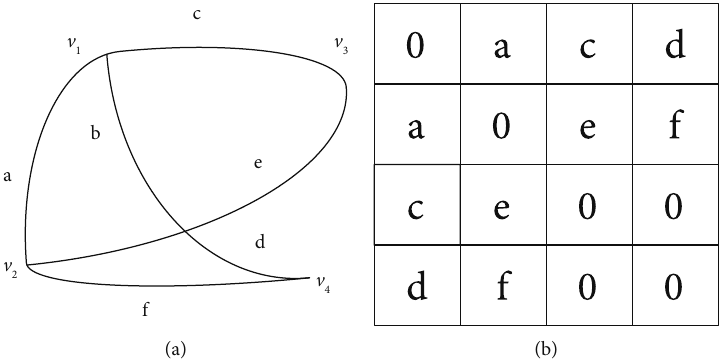
Figure 3: Basic representation of the graph: (a) simple undirected graph and (b) matrix representation of undirected